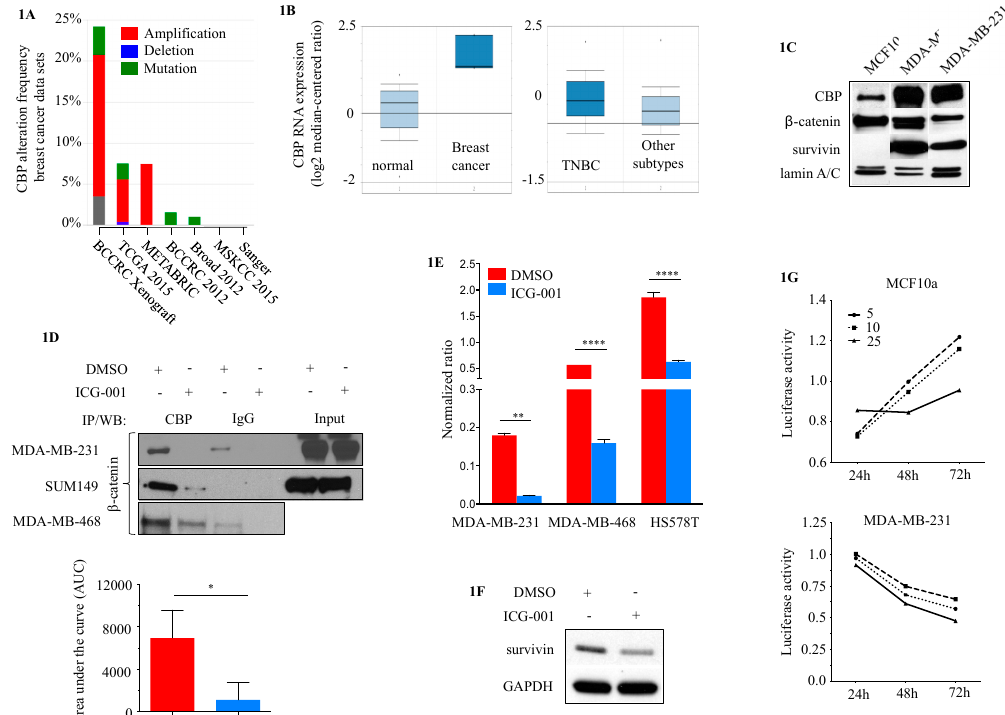
Figure 1. CBP as a potential target in TNBC. ( A ) Seven publicly available data sets showed genetic alterations in CBP in breast cancer (cBioPortal). ( B ) RNA expression levels of CBP in the TCGA BC data set ( n = 593); left box plot: normal breast tissue compared to BC (2.91-fold BC vs. normal, p = 0.015), right box plot TNBC compared to BC other subtypes (1.18-fold TNBC vs. others, p = 0.012) (Oncomine database). ( C ) CBP, survivin and β -catenin protein levels in two TNBC cell lines (MDA-MB-231, MDA-MB-468) and non-tumorigenic epithelial breast cell line MCF10a. ( D ) Co-Immunoprecipitation (CoIP) of CBP/ β -catenin in three TNBC cell lines (MDA231, MDA468 and SUM149) under DMSO vehicle control conditions and after treatment with 20 µ M ICG-001 for 24 h (DMSO 6961 ± 2647 vs. ICG-001 1093 ± 1640). The area under the curve (AUC) refers to summary results for MDA-MB-231, MDA-MB-468 and SUM149 for CBP/b-catenin binding under DMSO (red bar) and ICG-001 (blue bar) treatment conditions. ( E ) Survivin-promoter driven luciferase reporter activity in three TNBC cell lines (MDA-MB-231, MDA-MB-468 and Hs578T) treated for 24 h with 10 µ M ICG-001 or DMSO vehicle control. ( F ) Western blot for survivin expression MDA-MB-231 treated for 24 h with 10 µ M ICG-001 or DMSO vehicle control. (* p < 0.05, ** p < 0.01, **** p < 0.0001). ( G ) Cell viability of not non-transformed MCF10a cells (top panel) and MDA-MD-231 TNBC cells (bottom panel) treated for up to 72 h with different concentrations of